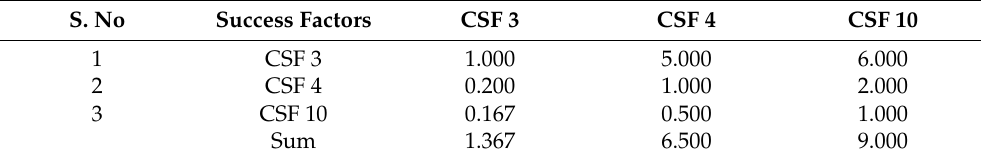
Table 18. Pairwise comparisons for standards level success factors.